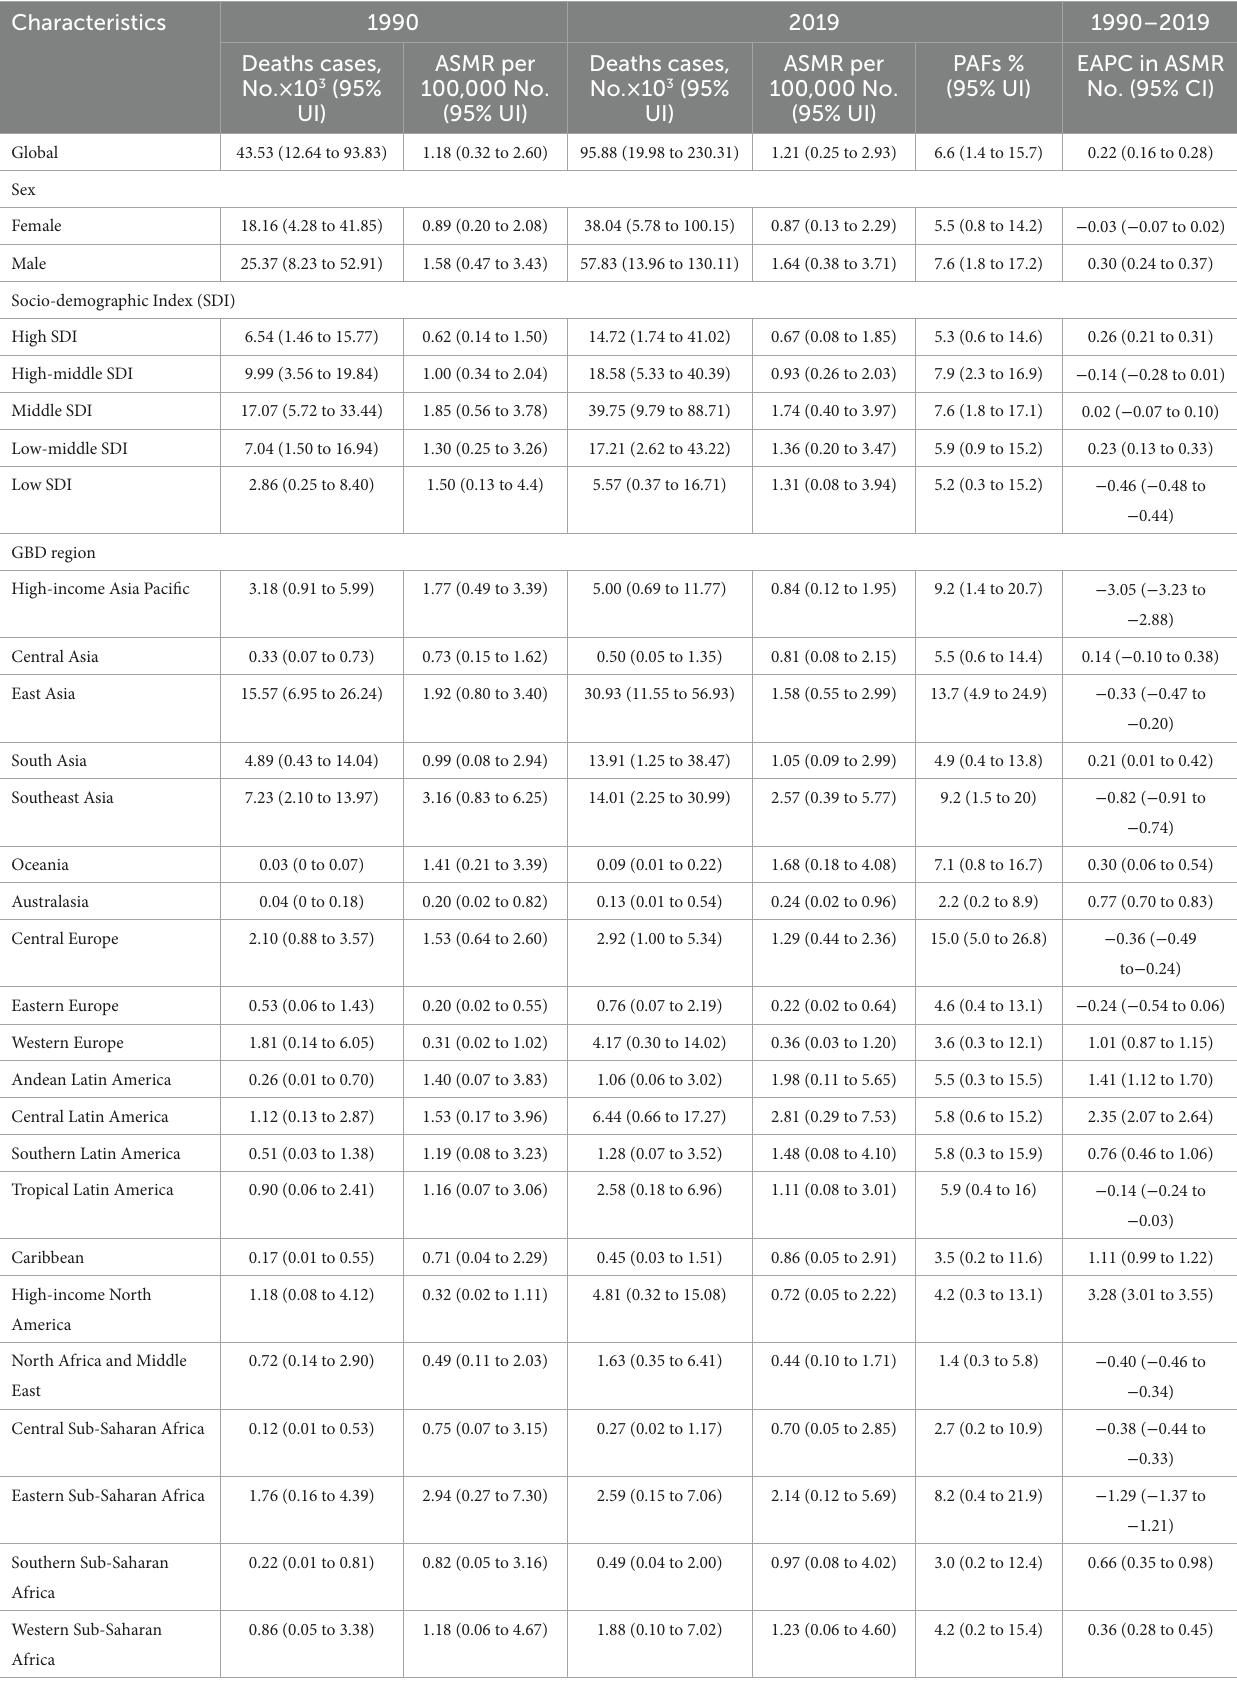
TABLE 1 Deaths and ASMR of chronic kidney disease attributable to high sodium intake in 1990 and 2019 and the temporal trends from 1990 to 2019.